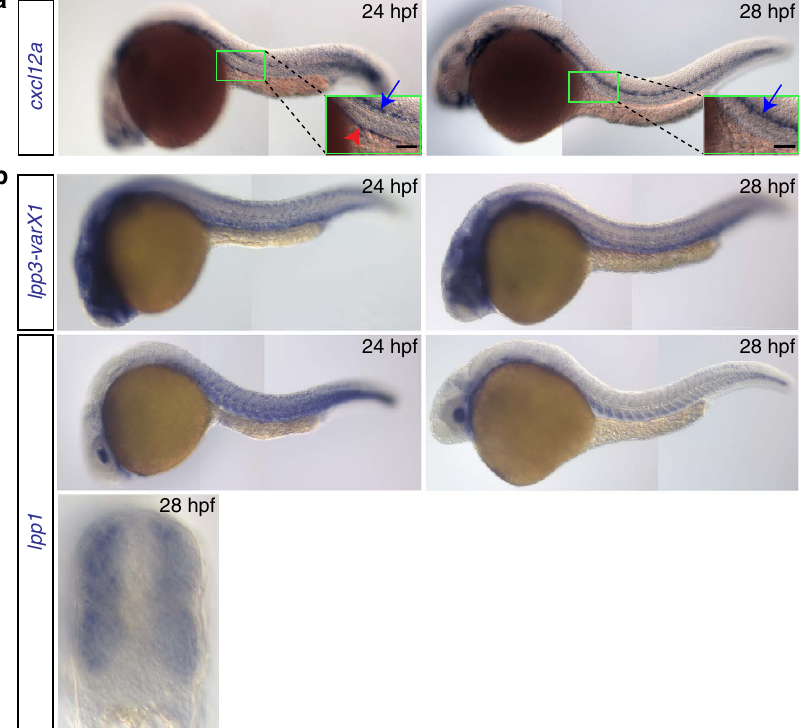
Figure 2 | Expression patterns of cxcl12a and lpp variants. ( a ) cxcl12a is expressed at the site where the gonad develops within a 24hpf embryo (green box and red arrowhead in the inset in the left panel), but not in 28hpf embryos (right panel). Higher expression level of cxcl12a is detected in the lateral line (blue arrows). Scale bar, 50 m m. ( b ) lpp1 (variants X1 and X2) and lpp3 are expressed in the somites and developing vessels. See also Supplementary Fig.